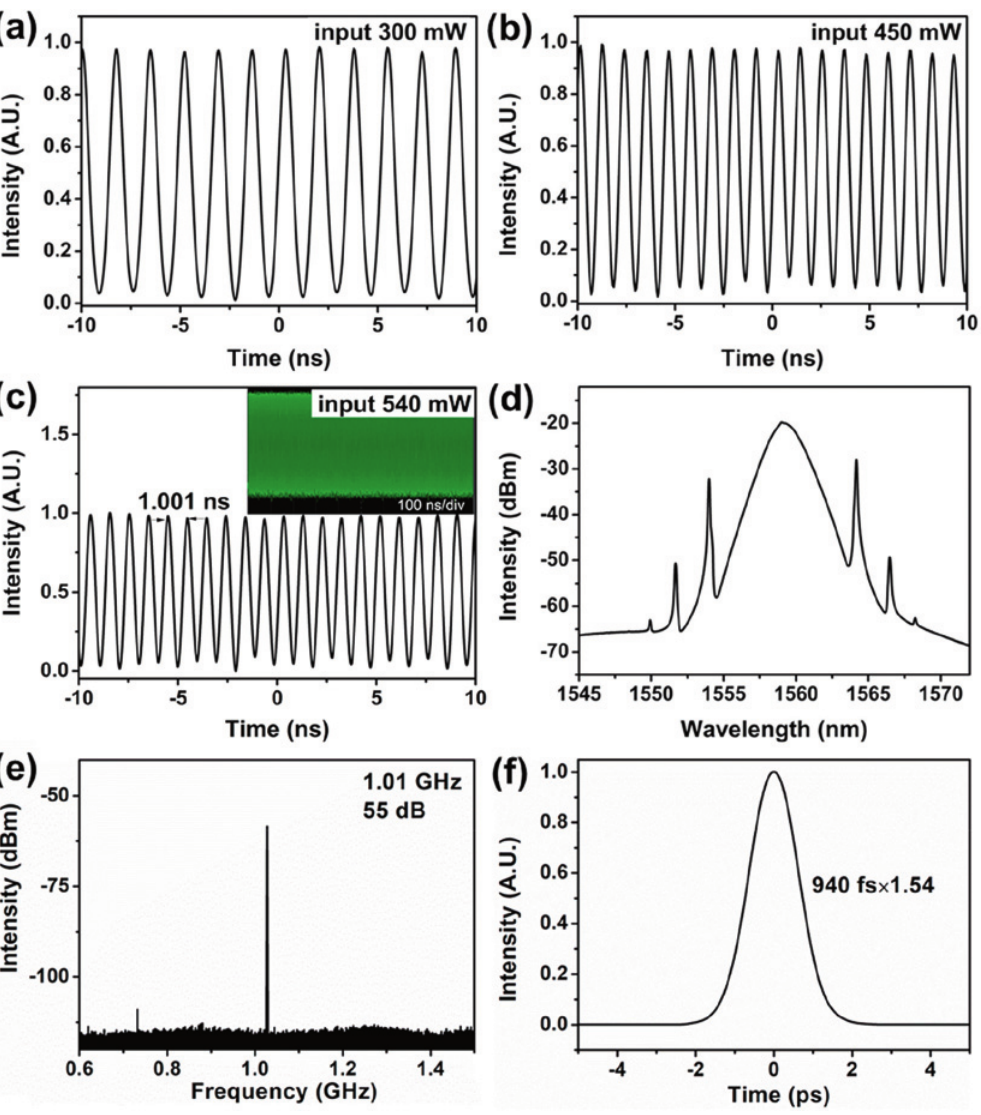
Figure 5: Harmonic mode-locked operation based on MXene V 2 CT x nanosheets. (a) Pulse train at pump power of 300 mW. (b) Pulse train at pump power of 450 mW. (c) Pulse train at pump power of 540 mW. (d) Optical spectrum. (e) RF spectrum. (f) Autocorrealtion.